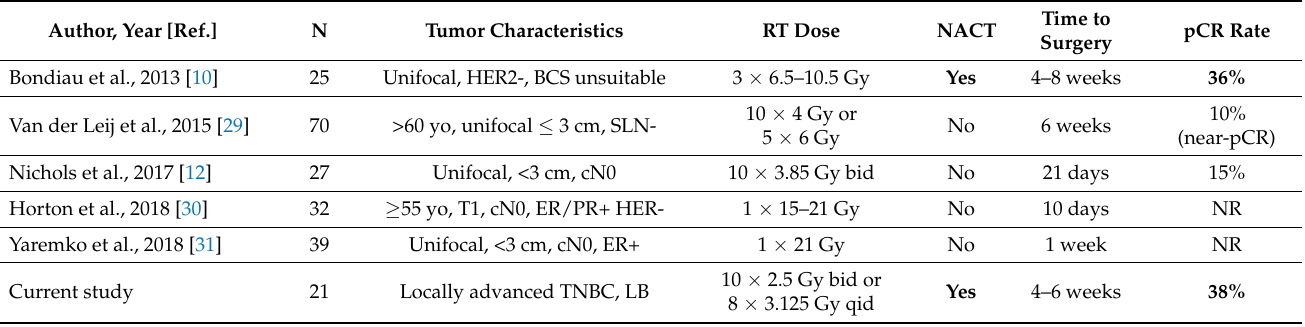
Table 5. Prospective studies assessing preoperative, tumor-directed